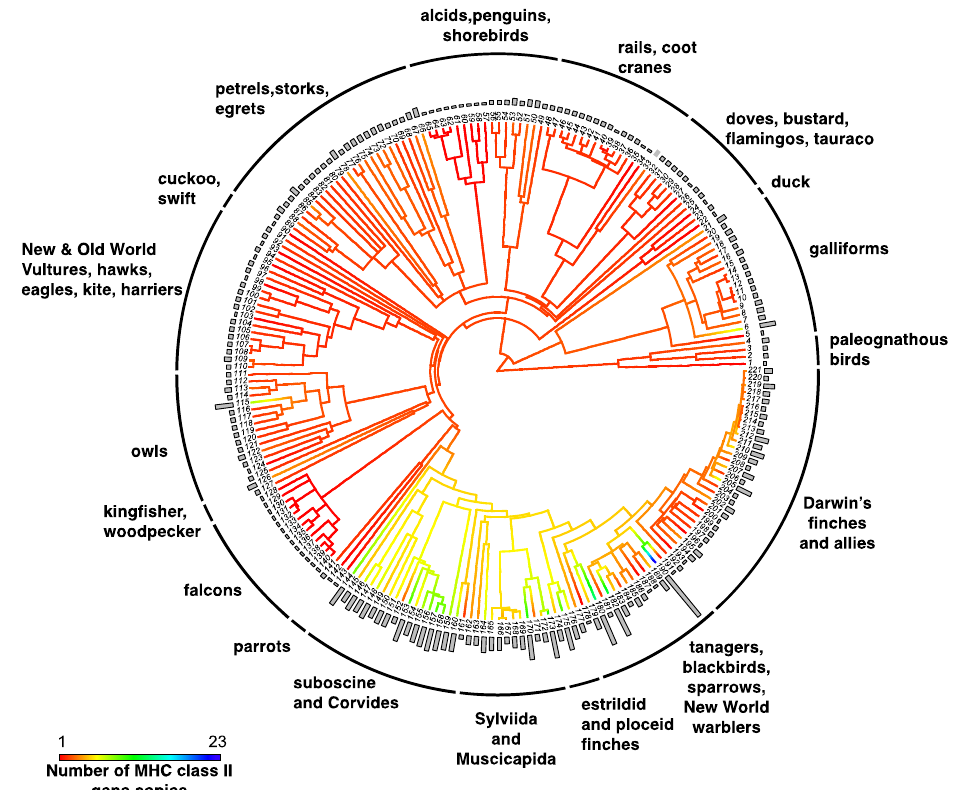
Figure 3. Ancestral character estimation of gene copy number at MHC class IIB genes along the branches and nodes of a tree for birds. Bars associated with each terminal node indicate the estimated number of MHC gene copies. Figure modified from Minias et al. 2018 [103]. Key to species names is supplied in Supplementary Table S1.